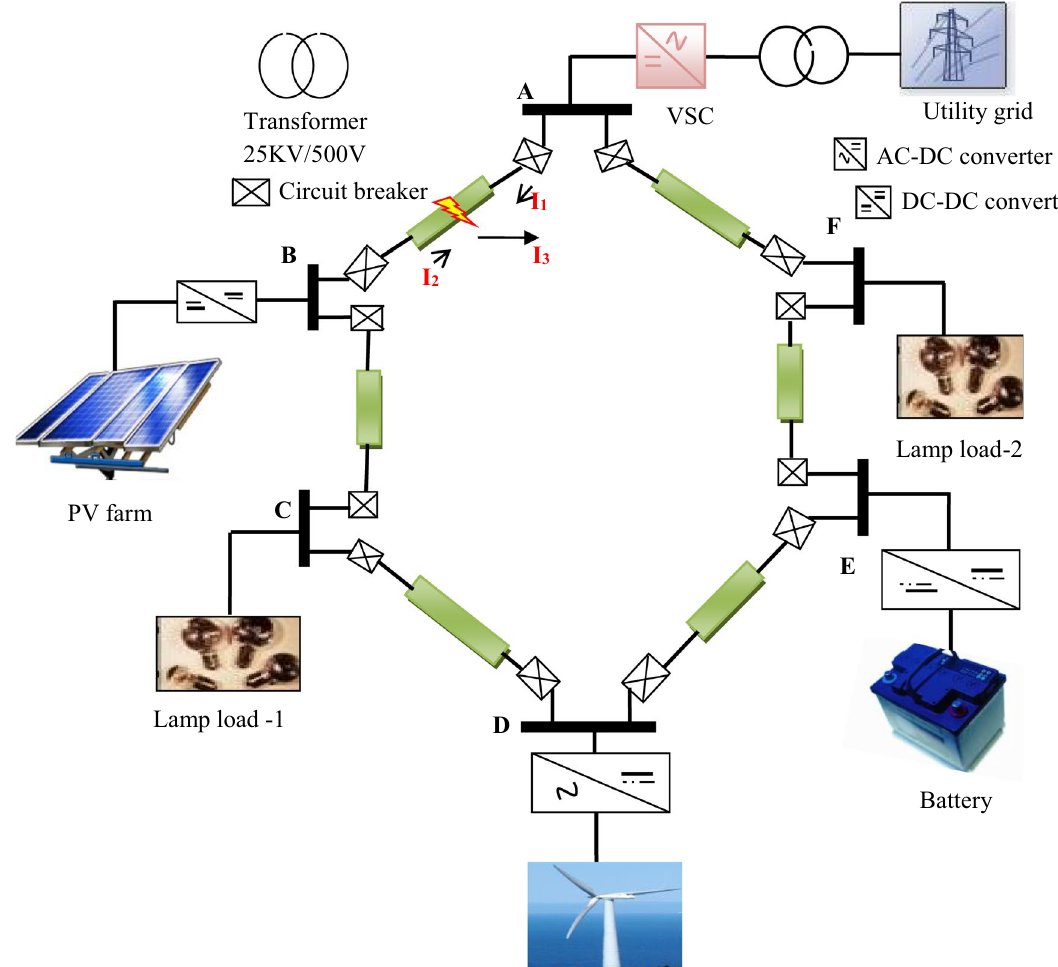
Fig. 2 PV-Wind based DC ring